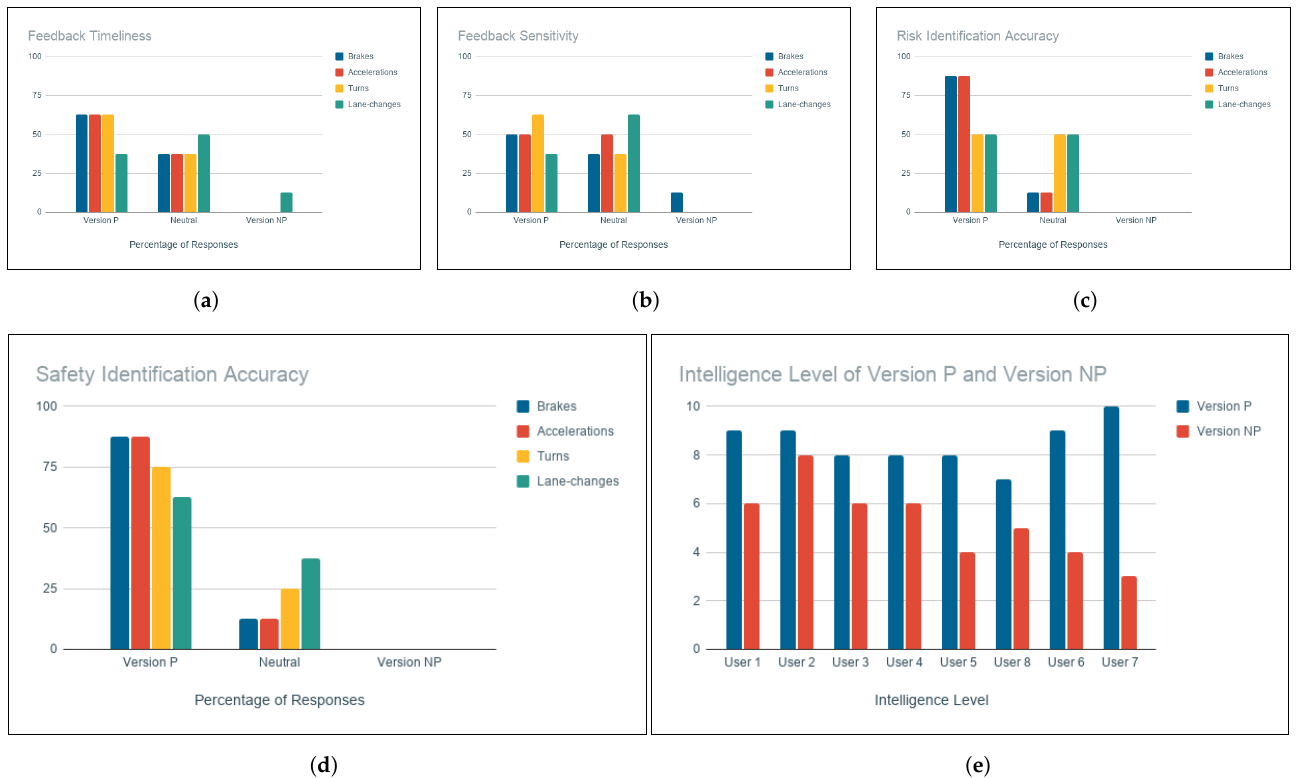
Figure 10. ( a ) Feedback timeliness. ( b ) Feedback sensitivity. ( c ) Risk identification accuracy. ( d ) Safety identification accuracy. ( e ) Level of